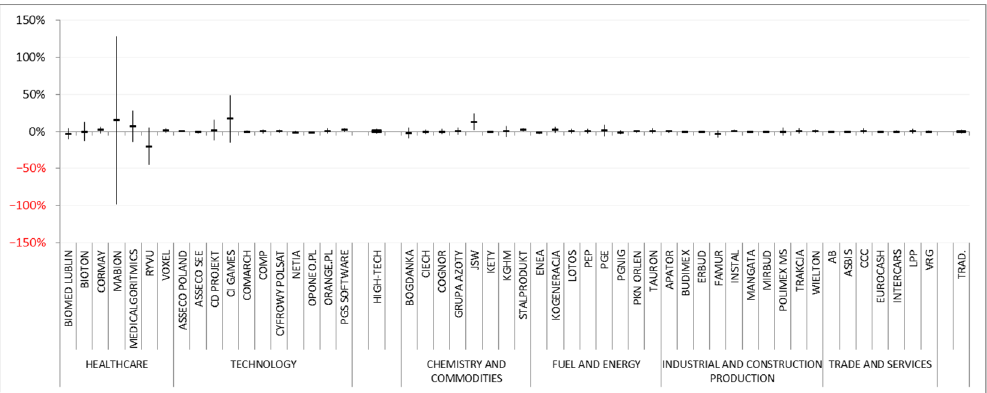
Figure 9. A typical area of variation of the operating cost level ratio in the surveyed enterprises. Source: own work.